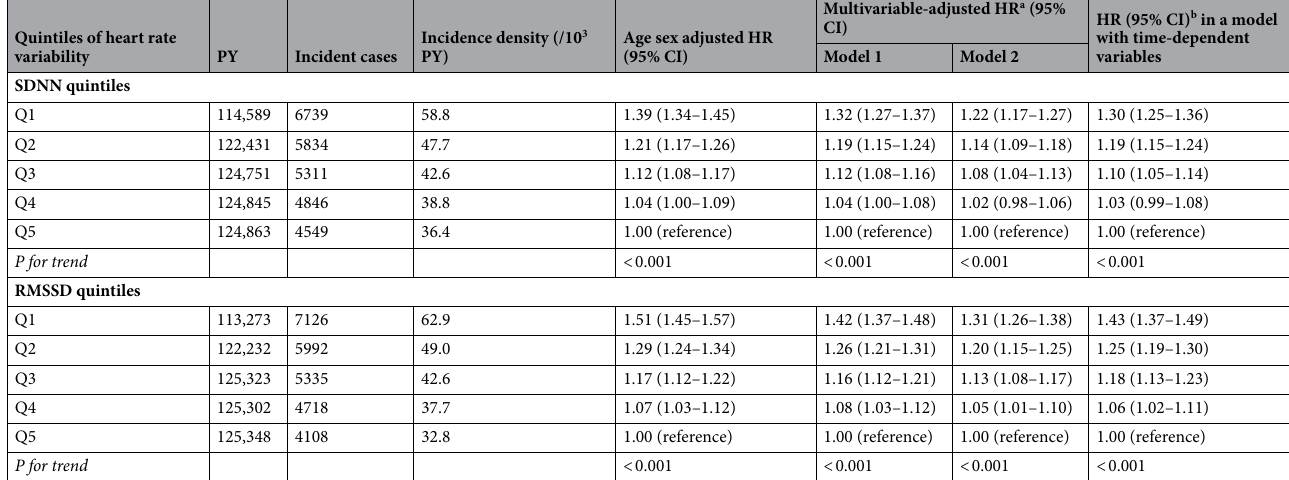
Table 2. The incidence of hepatic steatosis by heart rate variability. a Estimated from parametric proportional hazard models. The multivariable model was adjusted for age, sex, centre, year of screening examination, smoking, alcohol consumption, physical activity, depressive symptoms, sleep duration, education level, total energy intake, and systolic blood pressure. b Estimated from parametric proportional hazard models with quintiles of each heart rate variability (SDNN and RMSSD), smoking, alcohol consumption, physical activity, depressive symptoms, sleep duration, total energy intake, and systolic blood pressure as time-dependent categorical variables; and baseline age, sex, centre, year of screening exam, and education level as time-fixed variables. CI confidence interval, HR hazard ratio, PY person-year, RMSSD root mean square of successive differences in RR intervals, SDNN standard deviation of normal-to-normal intervals.